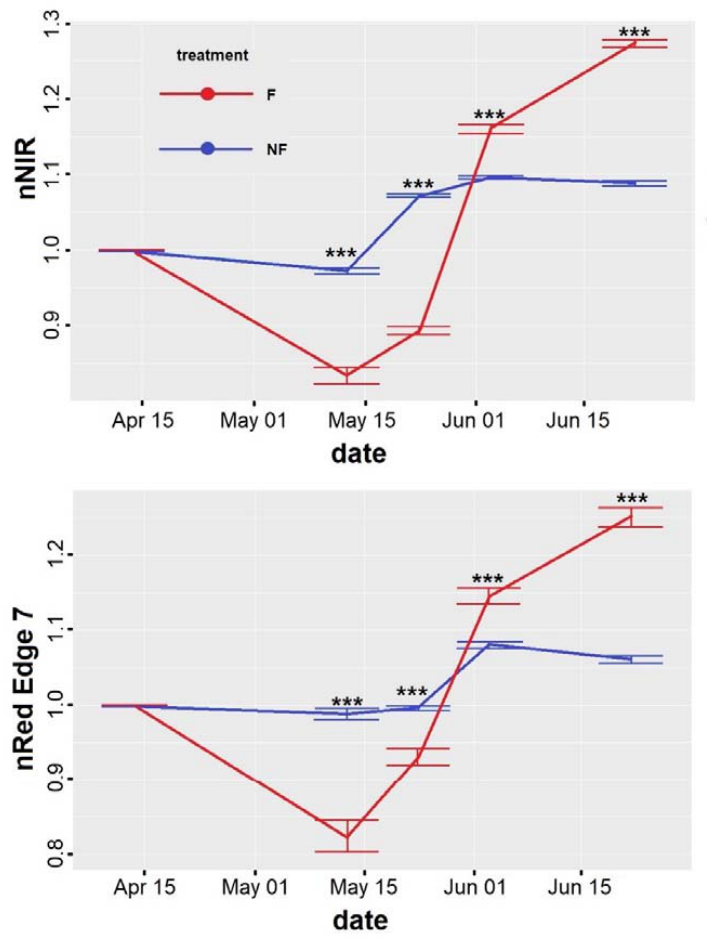
Figure 6. Change of normalized NIR and Red Edge (Sentinel-2 band 7) from May to June 2017. The values reported in y axis represent the reflectance values normalized on the first date, equating to 1. Statistical significance was determined by Student’s t -test. Single asterisk indicates a statistical di ff erence between treatments, p < 0.05; double asterisk indicates a significant di ff erence, p < 0.01; triple asterisk indicates a statistical di ff erence, p < 0.001 (unpaired t -test). Error bars represent standard error of the mean.